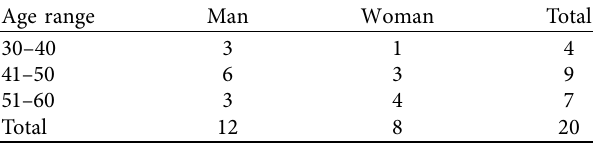
Table 1: General information of experimental